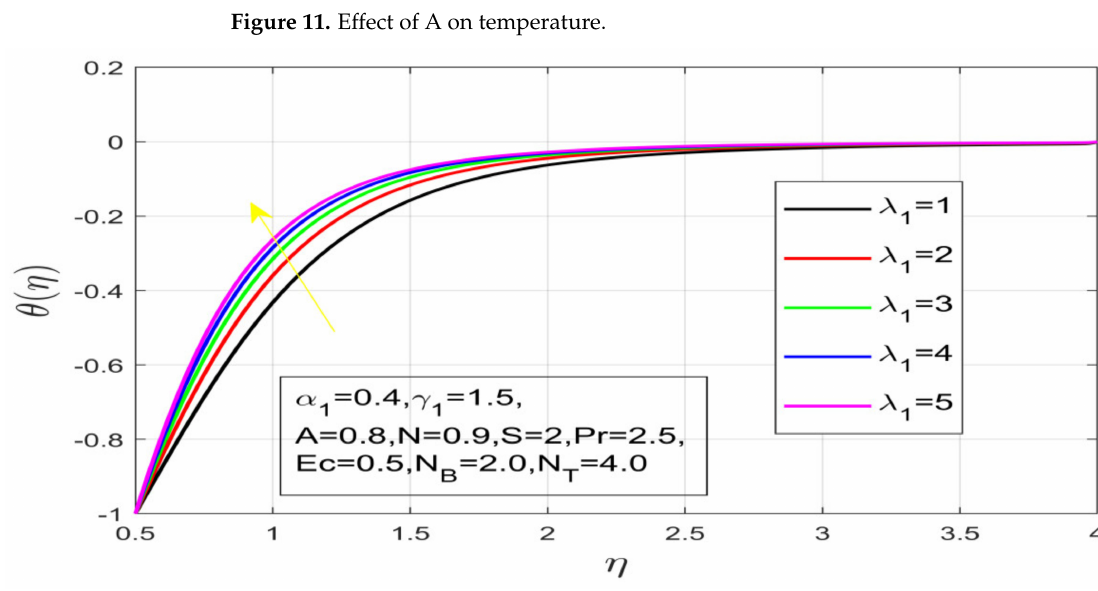
Figure 12. Impact on λ _1 on temperature.